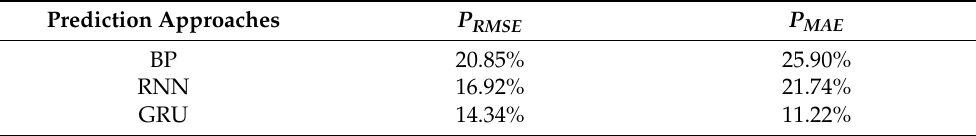
Table 6. Percentage improvements of the LSTM method in comparison with the other single NN approaches on propagation loss sequence 1 (evaporation